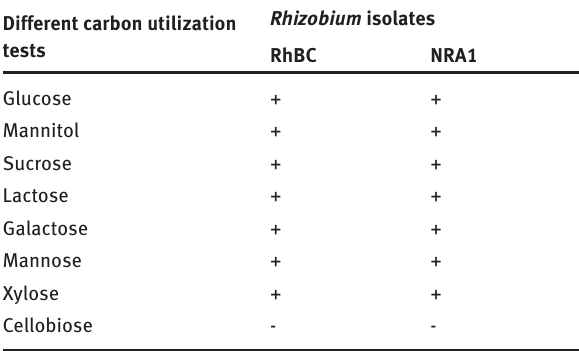
Table 3: Utilization of carbon sources by Rhizobium isolates Different carbon utilization tests